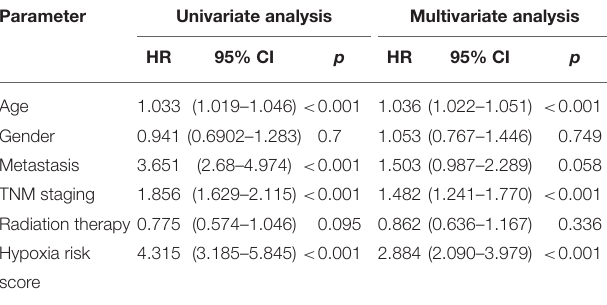
TABLE 2 | The univariate analysis and multivariate analysis of the hypoxia risk